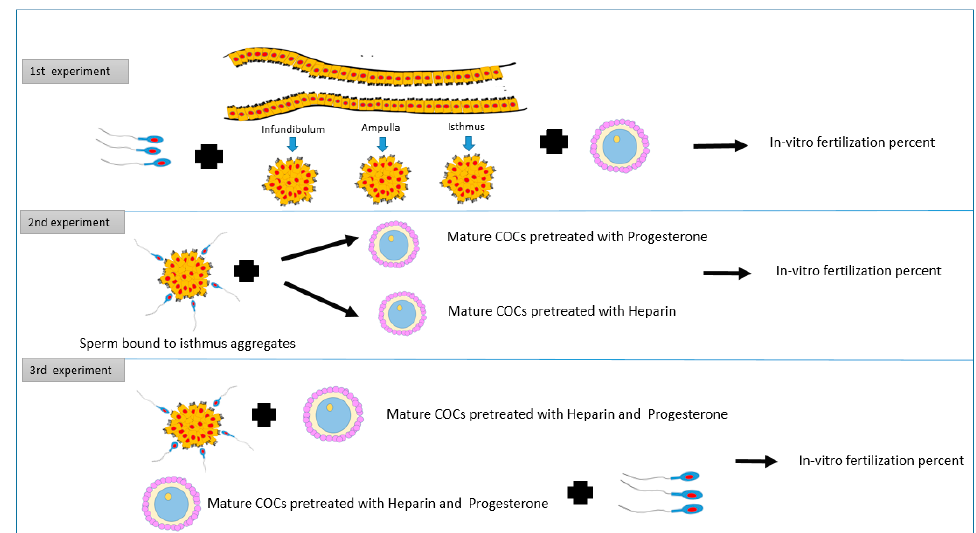
Figure 1. The study design shows three experiments. The first one evaluates the pre-incubation of sperm with cell aggregates from different oviduct segments on the in-vitro fertilization rate. The second experiment shows the impact of the addition of mature COCs treated with heparin or pro- gesterone to sperm pre-incubated with isthmus cells aggregates on in-vitro fertilization outcomes. The third experiment aims to assess the influence of the addition of mature COCs treated with hep- arin and progesterone to sperm pre-incubated with isthmus cells aggregates on in-vitro fertilization outcomes.